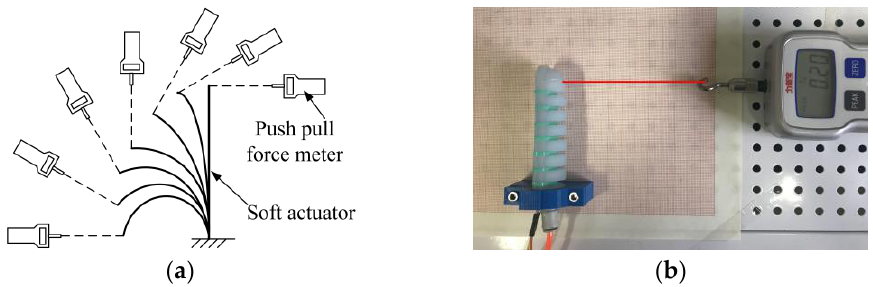
Figure 16. Output force experiment at the end of soft actuator. ( a ) Schematic diagram of the output force test at the end of the soft actuator. ( b ) Experimental diagram of the output force at the end of the soft actuator.